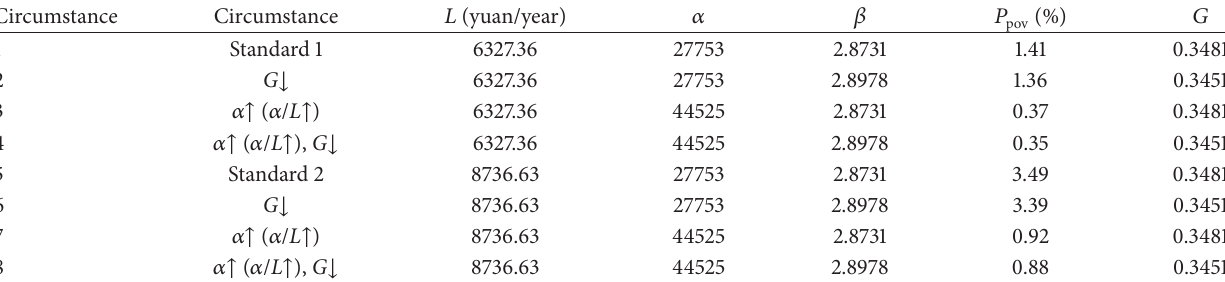
Table 7: Urban poverty ratio in different situation.